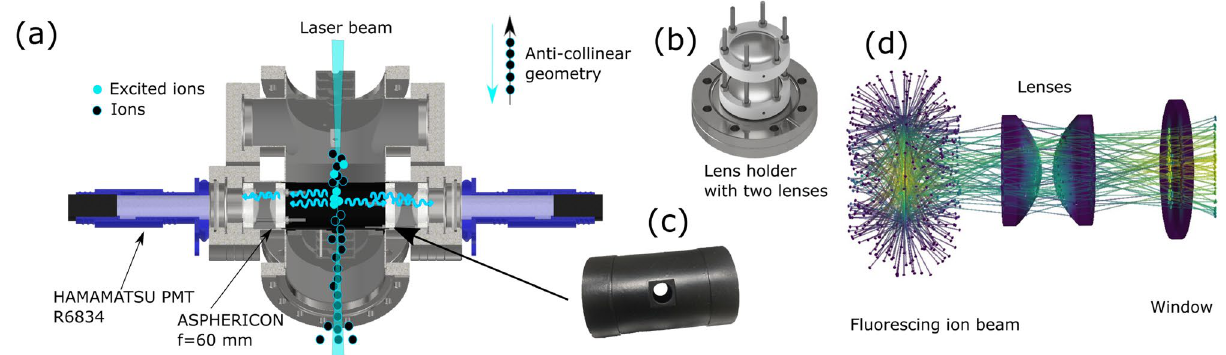
Figure 1. The light collection chamber installed for the measurement of Co II. ( a ) Custom-made chamber with 4 windows for light collection. The length is 34 cm and the distance between the two rows for the optical detection system is 12 cm. ( b ) Lens assembly for imaging the ion beam onto a photomultiplier tube. For different wavelengths, the position of the lenses can be optimized for maximum efficiency. ( c ) Black cylinder for minimizing the background rate due to scattered laser light. ( d ) Simulation of the light collection systems using the Raosi python package. This algorithm is used to obtain the optimal distance of the lenses and PMT for a given